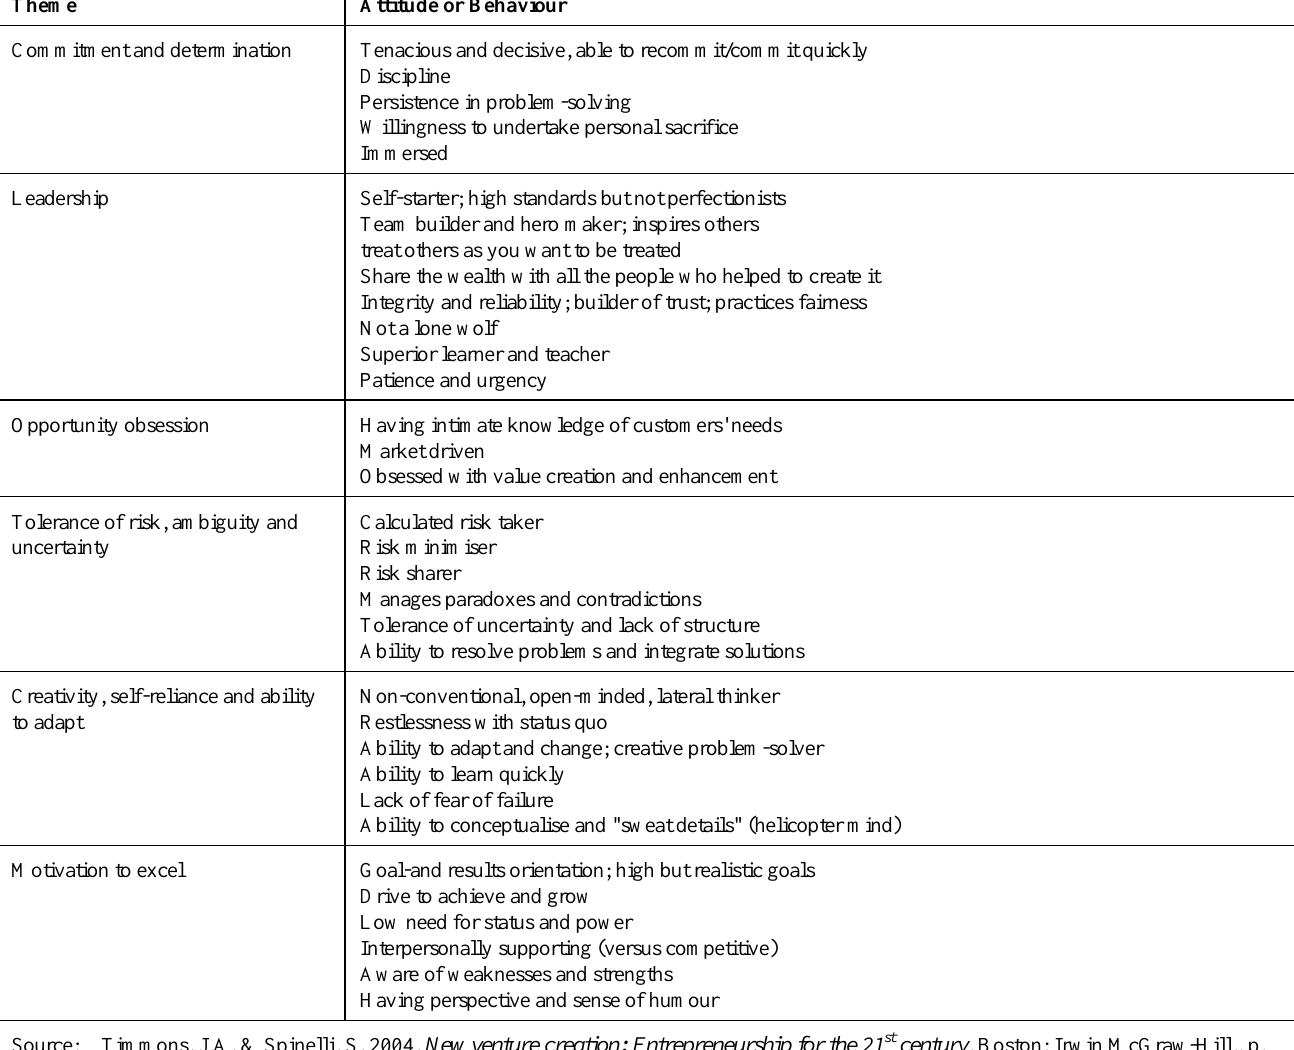
Table 3: Constructs of entrepreneurship Theme